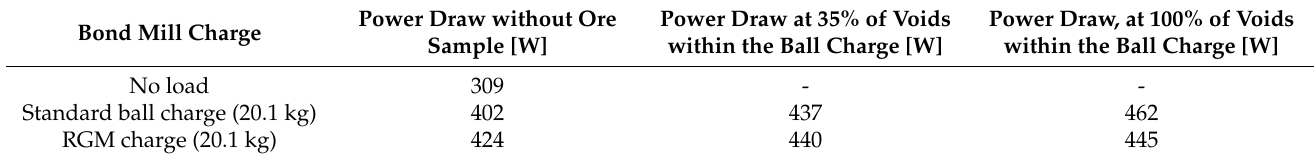
Table 6. Power draw measurements in a Bond ball